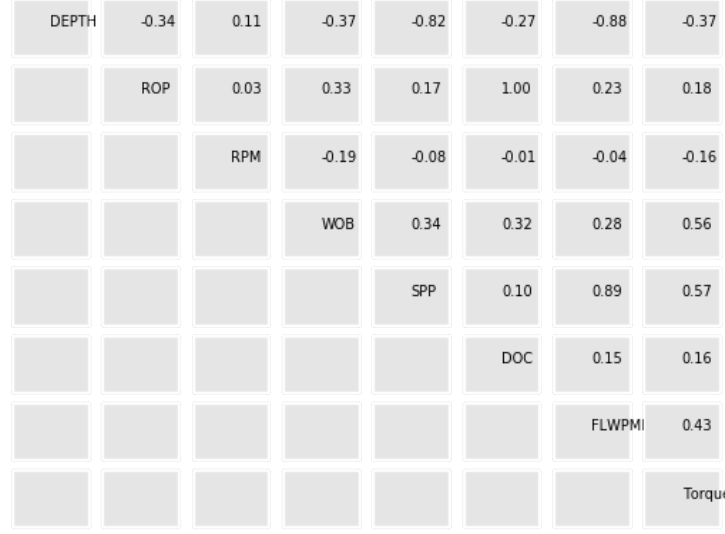
Figure 3. Pairs plot between the drilling variables for Well